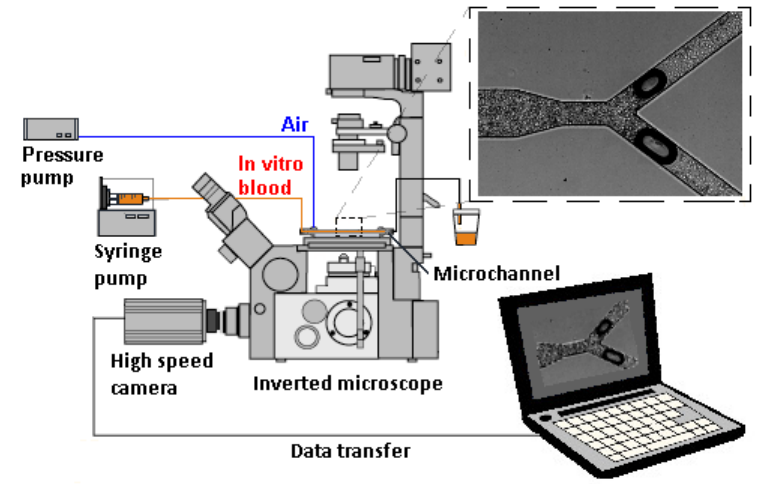
Figure 2. Schematic diagram of the experimental set-up used in this study.